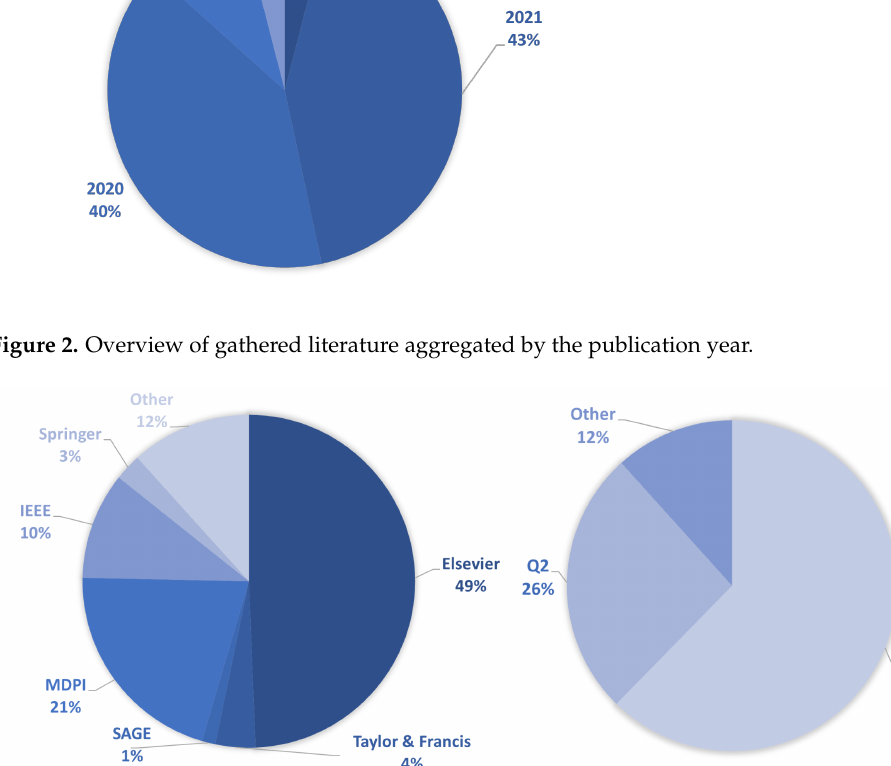
Figure 3. Overview of gathered literature concerning both the publishing organization and quartile- based ranking of the corresponding